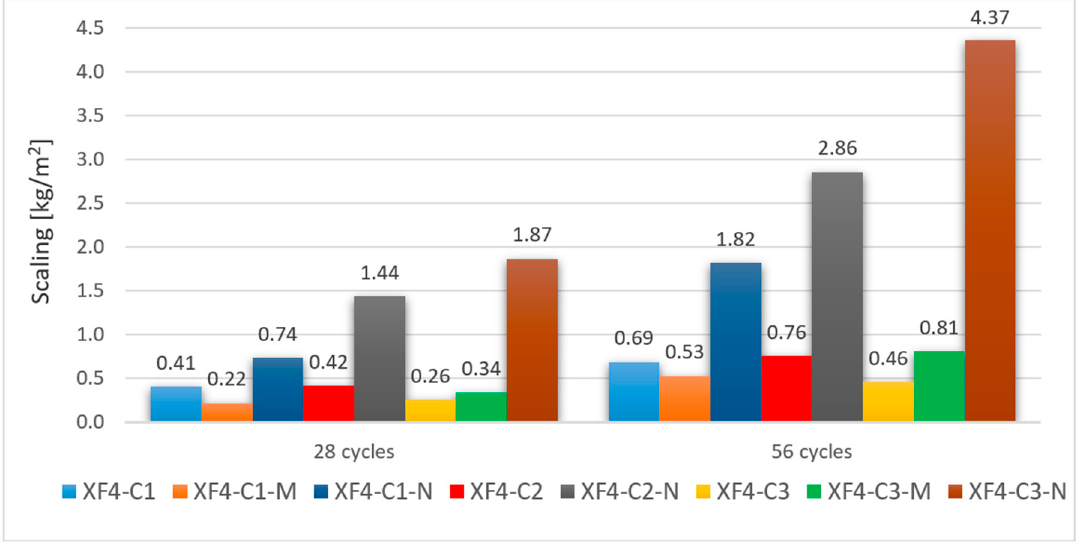
Figure 10. De-icing salt resistance test results (90 days of curing).